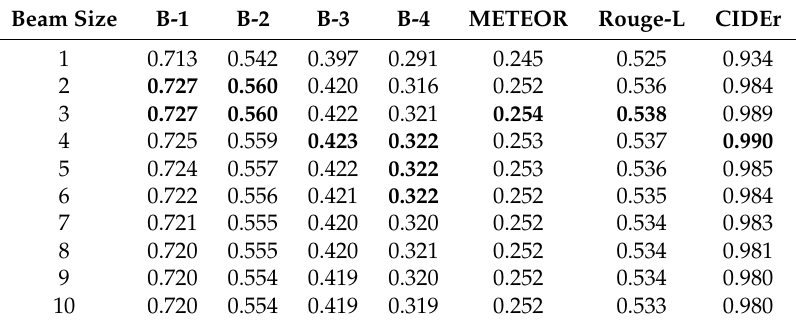
Table 2. Results our model on different beam size.